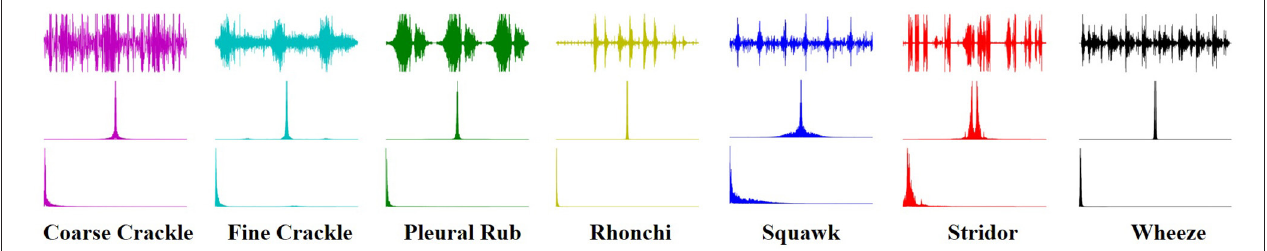
FIGURE 2 | Texture analysis of